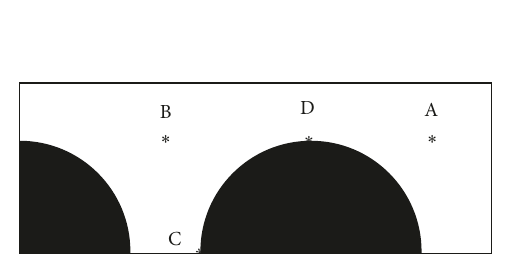
Figure 59: Position of the probes in POSEIDON.